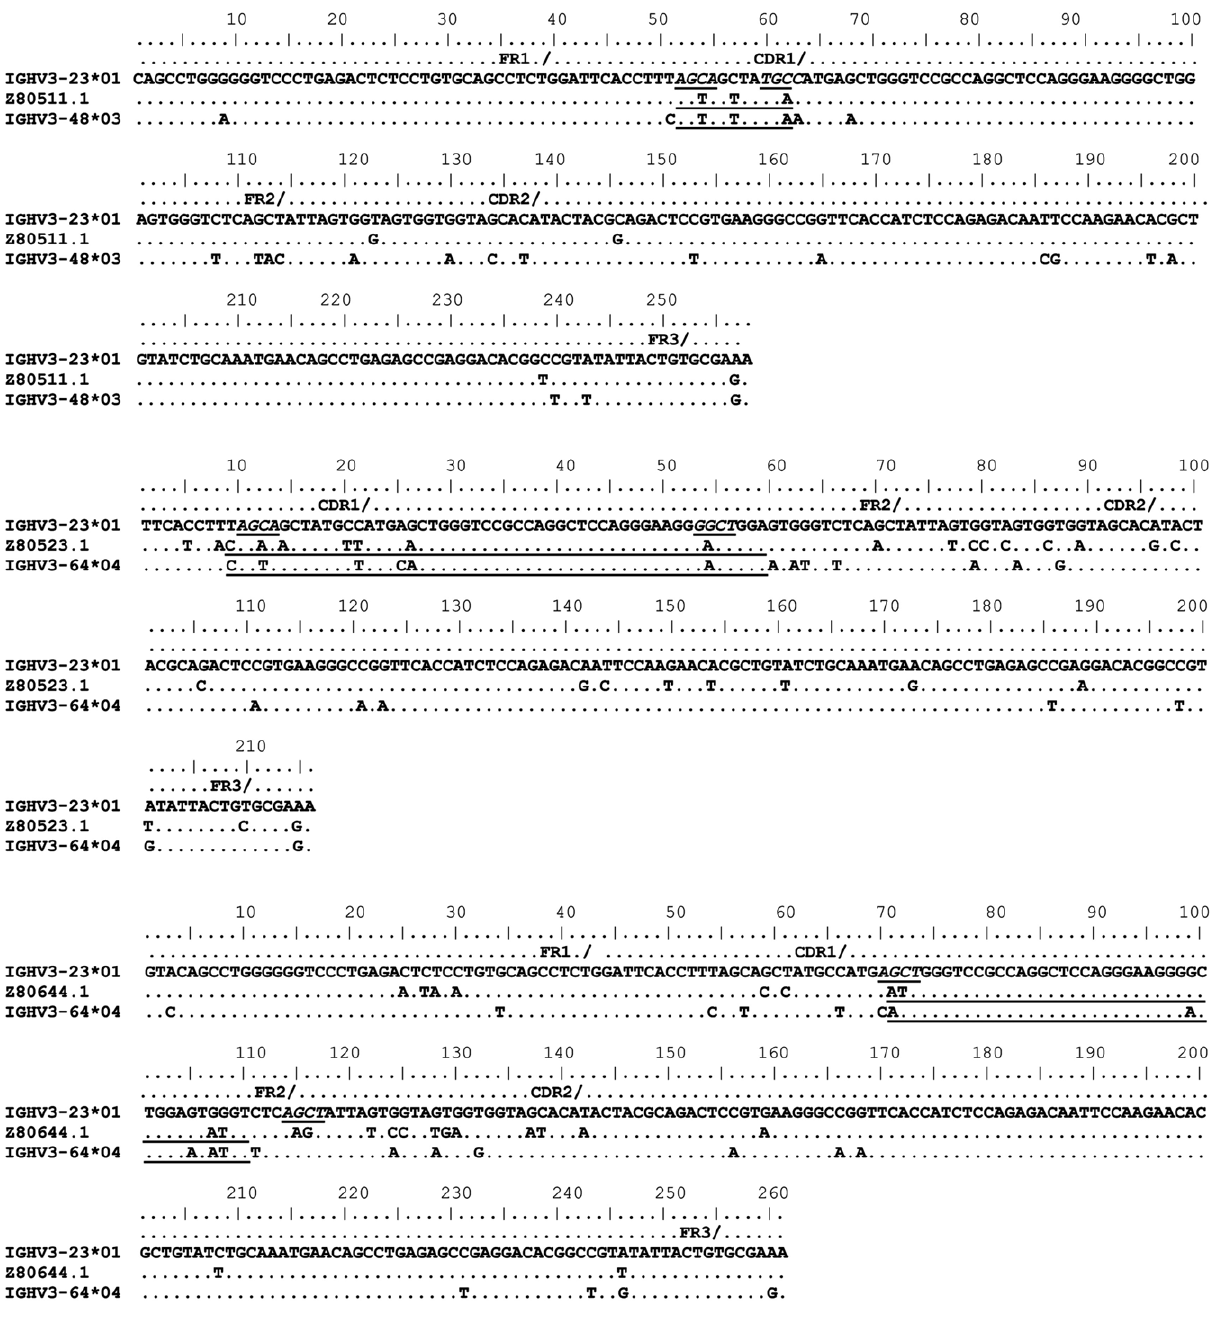
FIGURE 3 | Gene conversion-like events between rearranged IGHV3-23*01 gene sequences and germlineVH sequences superimposed by somatic hypermutation (SHM). IGHV3-23*01 mutated sequences obtained by single-cell PCR from CD19 + IgM + CD5 + B cells (Brezinschek et al., 1995, 1997; Dörner et al., 1998; Longo et al., 2008).Topmost sequence